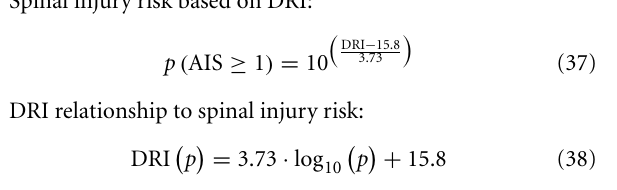
compression to the DRI.The blue dots are individual sled tests, the solid line is the linear fit, and the dashed lines are the 95% confidence. (C) The resulting injury risk function forTHOR thoracic spine axial compression